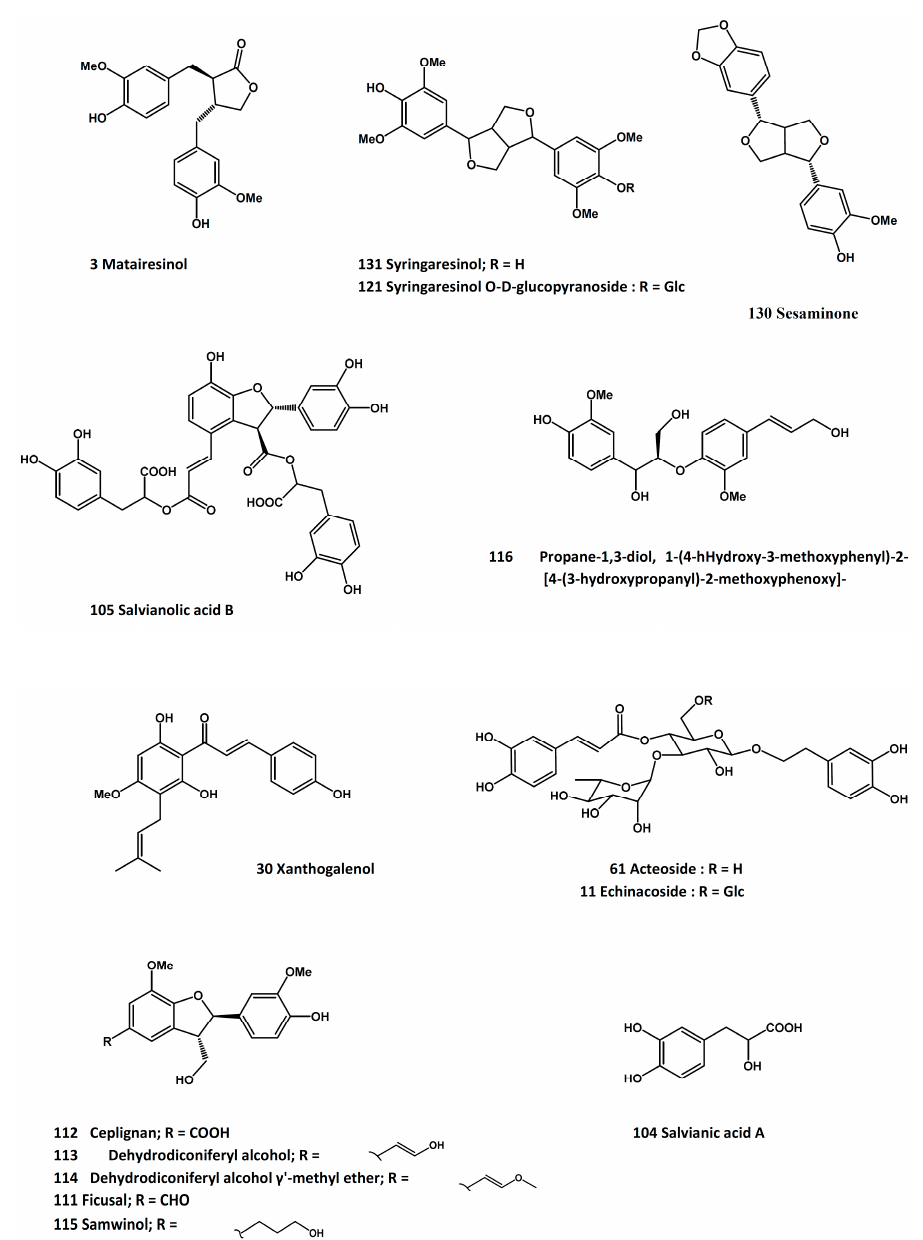
Figure 2. Phenylpropanol Derivatives and Lignans Reported to Possess Osteoprotective Property.